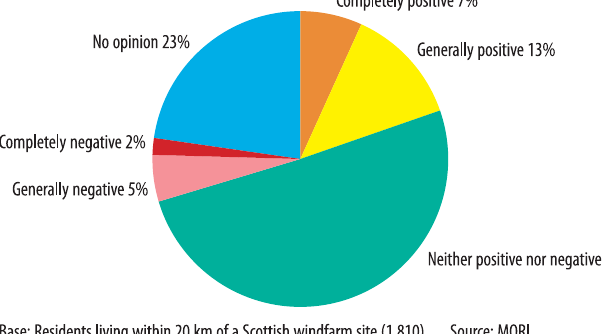
Figure 2. Perceived impact of wind